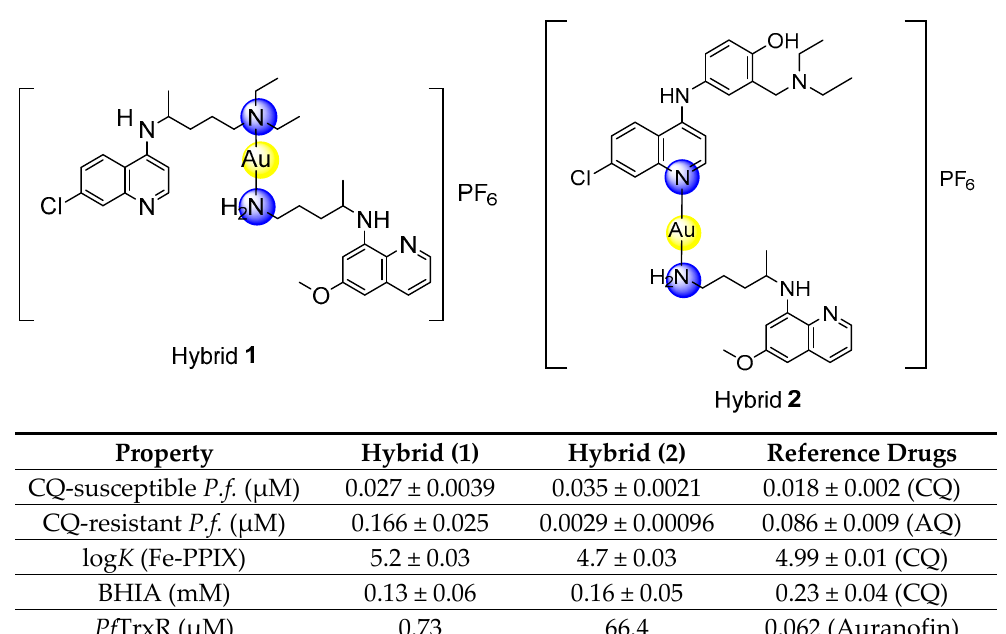
Figure 5. Summary of the structure–activity relationships and drug properties for the gold(I) hybrids. CQ, chloroquine; AQ, amodiaquine.